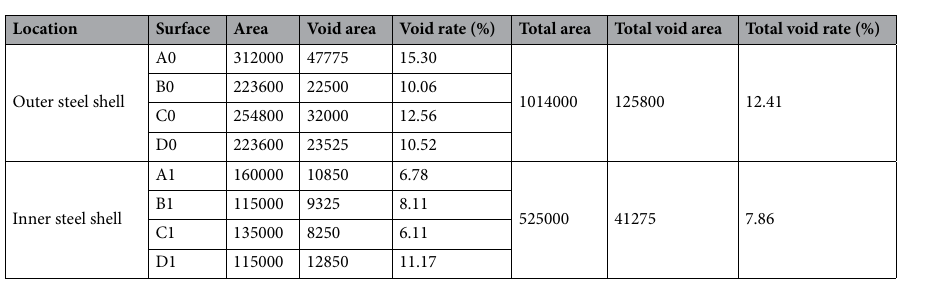
Table 4. Void data statistics table (Unit: cm